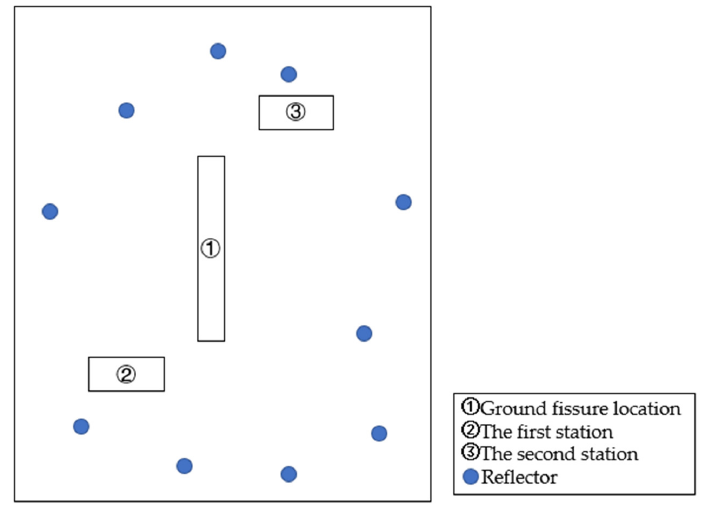
Figure 5. Position of reflectors.